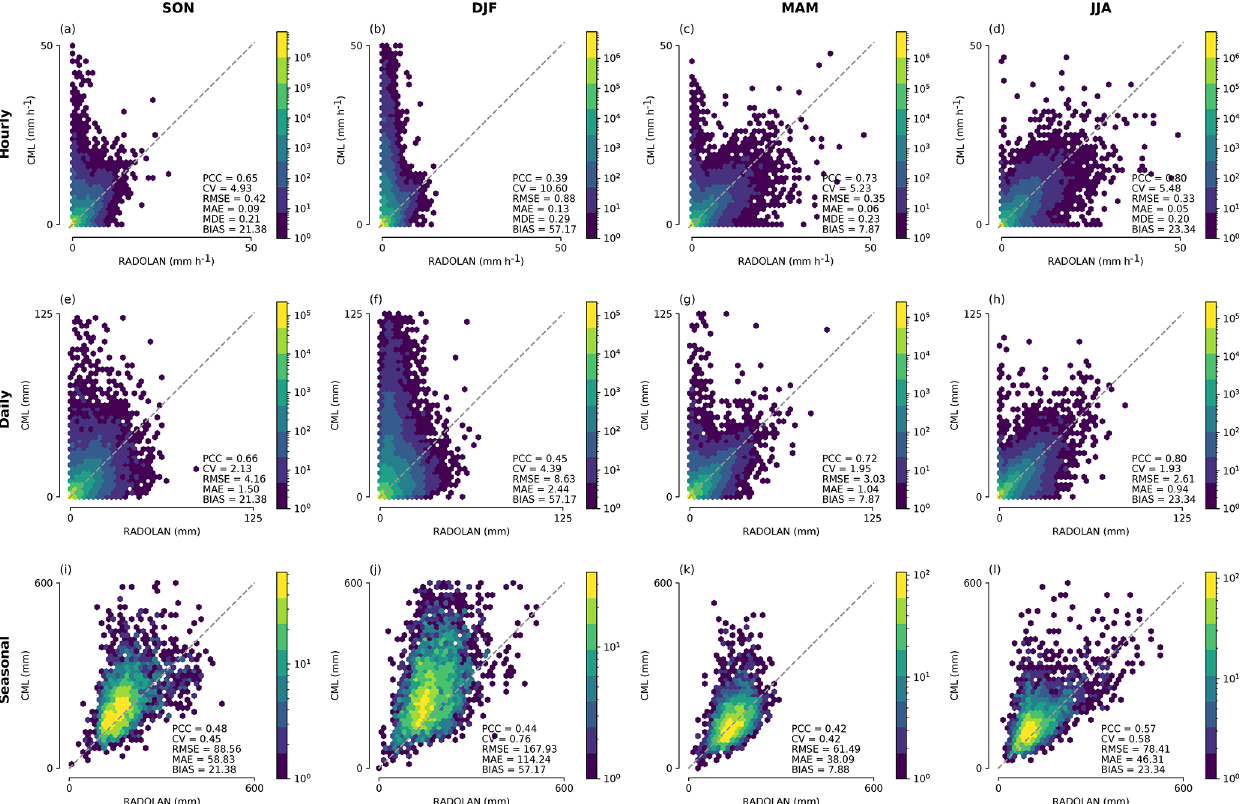
Figure 6. Seasonal scatter density plots of CML-derived rainfall and path-averaged RADOLAN-RW data for hourly (a–d) , daily (e–h) , and seasonal (i–l) aggregations with the respective performance metrics calculated from all available data pairs.